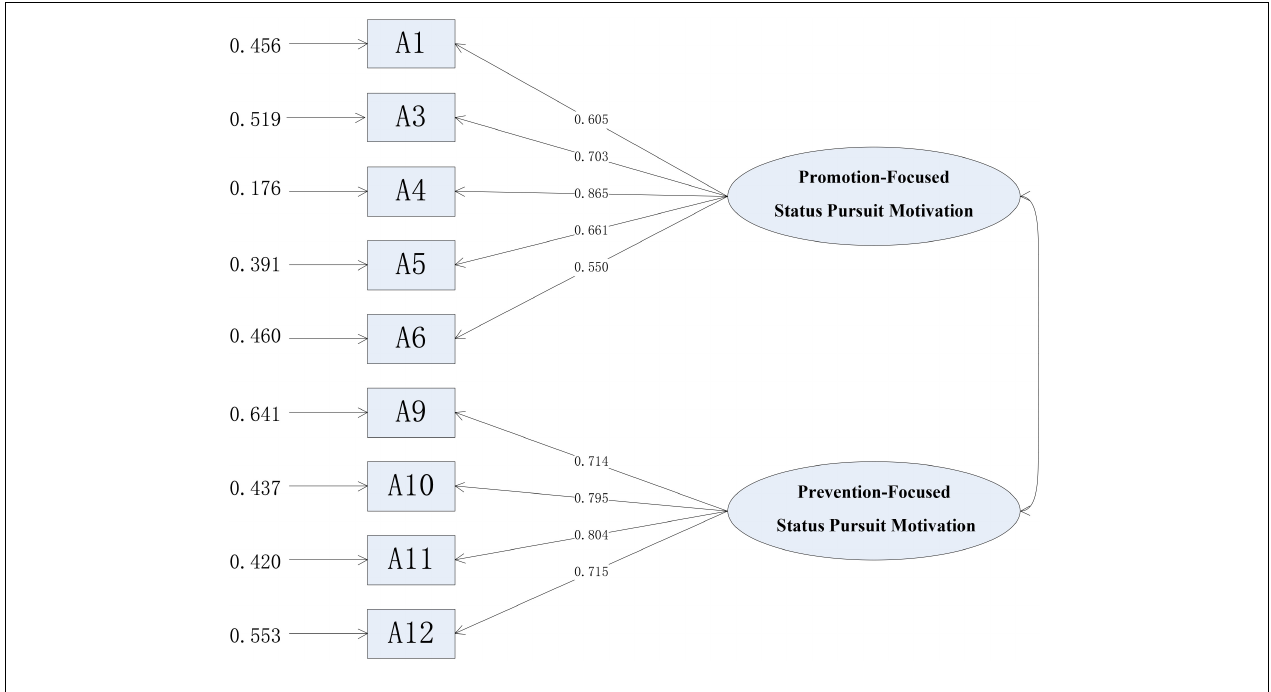
FIGURE 1 | Confirmatory factor analysis. TABLE 6 | Results of confirmatory factor analysis ( N =